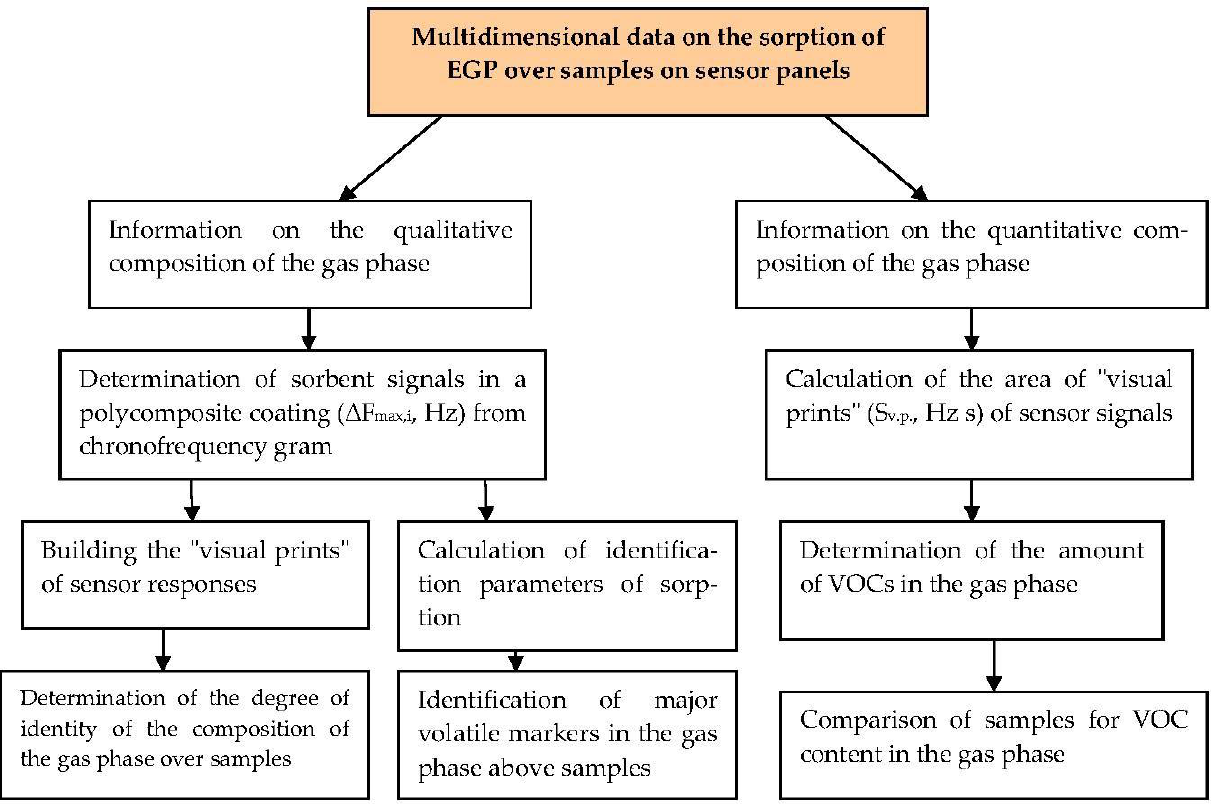
Figure 6. Scheme of the algorithm for processing output data from sensors with polycomposite coatings.